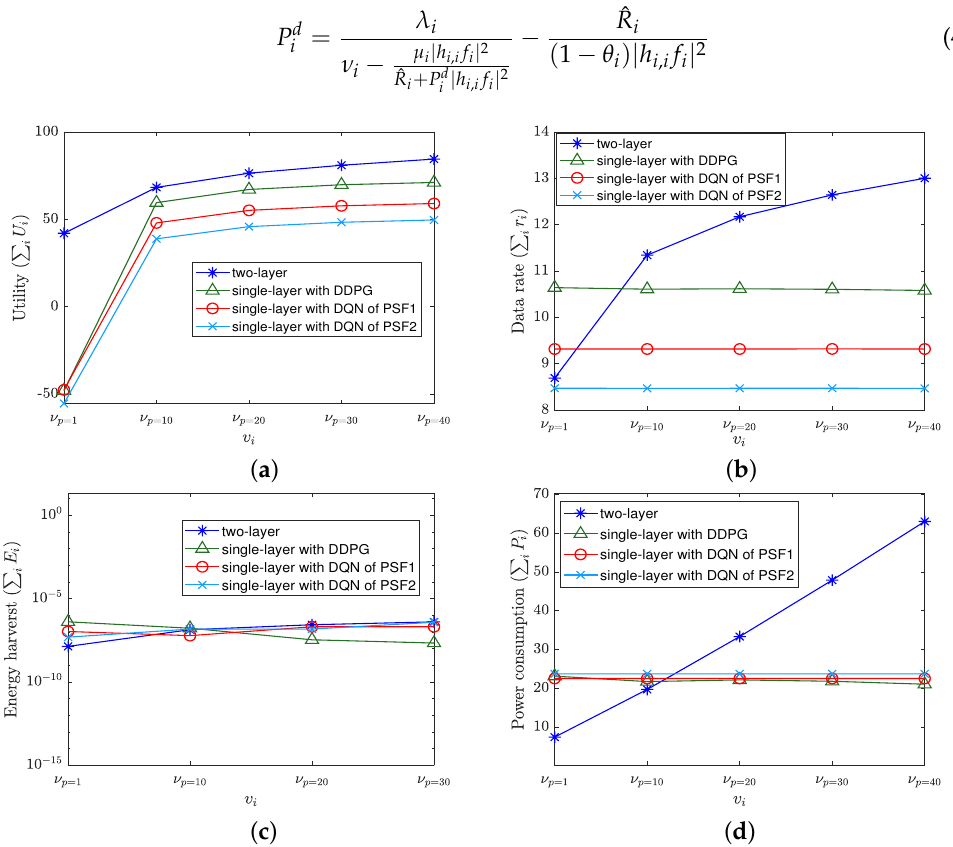
Figure 5. Impacts of the pricing strategy upon ( a ) utility, ( b ) data rate (bps), ( c ) energy harvesting (J), and ( d ) power consumption